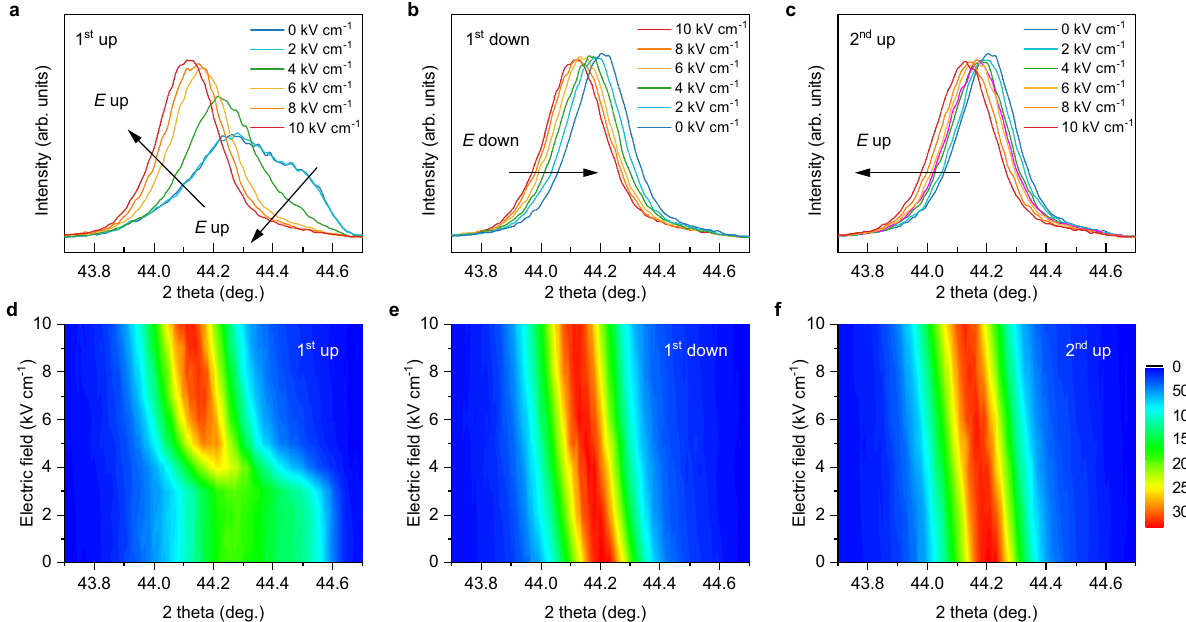
Fig. 4 Electric- fi eld-induced structure evolution. In-situ electric fi eld XRD patterns of textured PMN-PZT-3BT ceramics. a Increase electric fi eld on unpoled sample, denoted as 1st up. b Then decrease electric fi eld to 0, denoted as 1st down. c Then increase the electric fi eld again, denoted as 2nd up. d Contour plots of in-situ XRD data from ( a ). e Contour plots of in-situ XRD data from ( b ). f Contour plots of in-situ XRD data from ( c